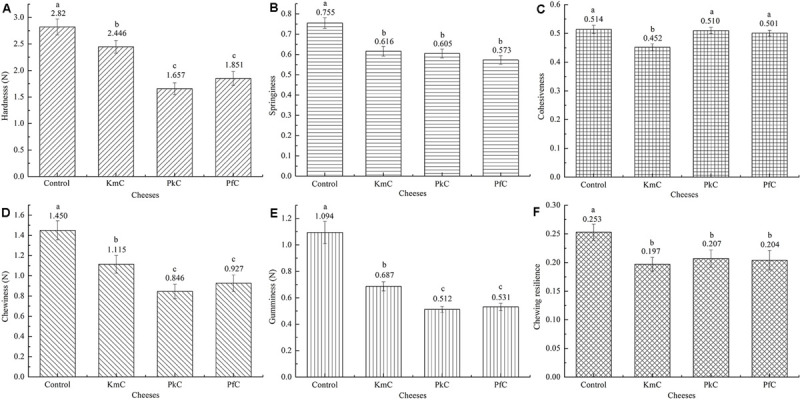
Texture analysis of four cheeses. The letters control, KmC, PkC, and PfC represent cheeses fermented by a commercial lactic acid starter, a commercial lactic acid starter with K. marxianus A2, P. fermentans A19, and P. Kudriavzevii A11, respectively. The letters in the column chart indicate whether the difference among data was statistically significant. (A–F) Represent hardness, springiness, cohesiveness, chewiness, gumminess and chewing resilience, respectively.